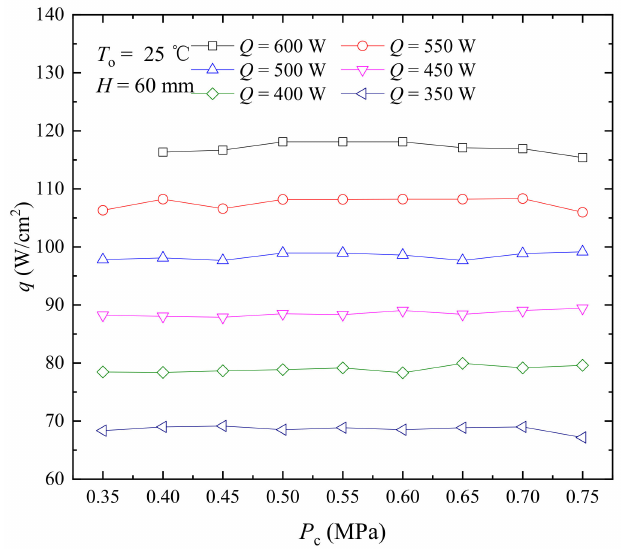
Figure 7. Curves of heat flux with a refrigerant charge at different heating power.